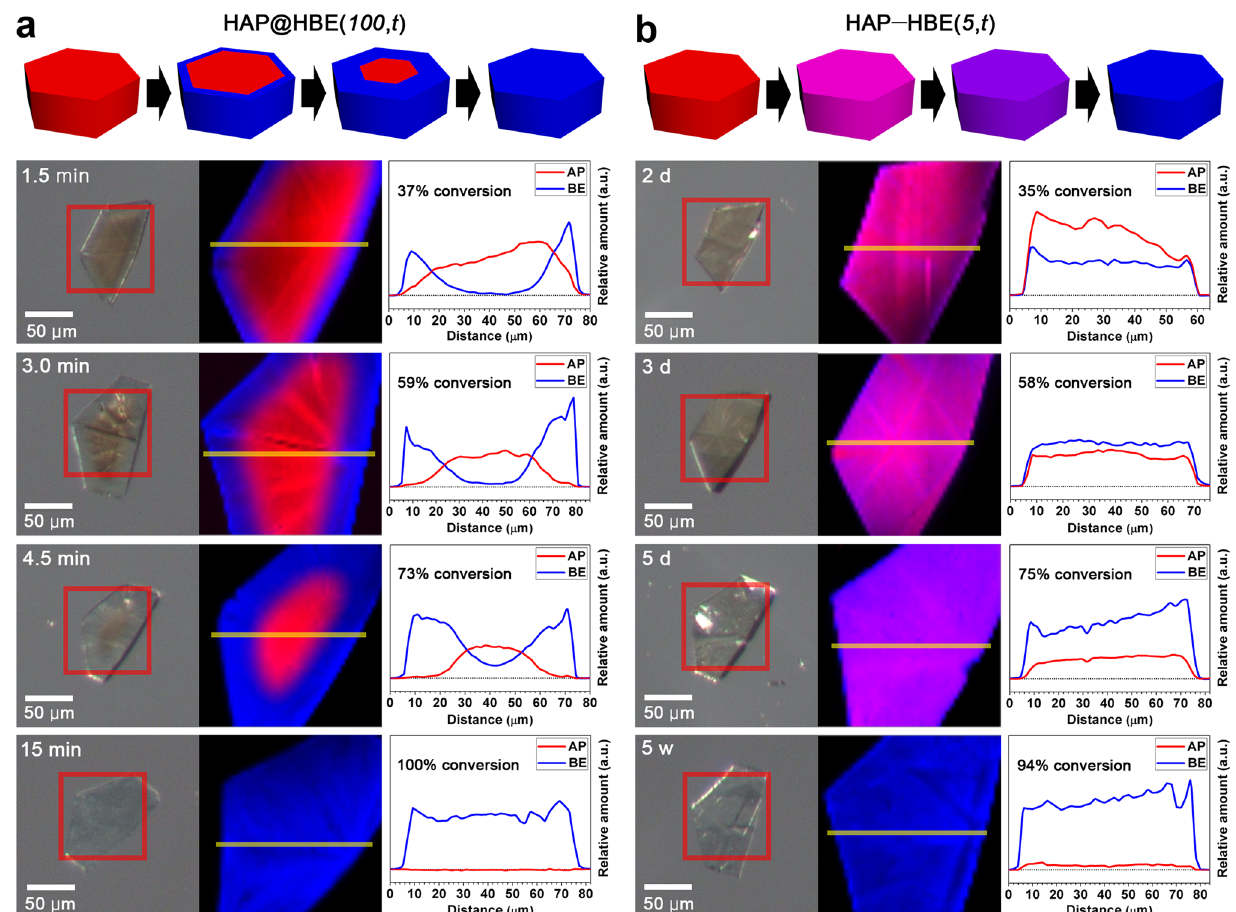
Fig. 3 Raman maps of AP and BE pillars during forward pillar exchange from HAP to HBE. a Schematic diagrams, optical photographs, Raman maps, and relative amounts of AP and BE pillars showing concentric pillar distribution in the core – shell intermediates, HAP@HBE 0.37 (100,1.5m), HAP@HBE 0.59 (100,3m), and HAP@HBE 0.73 (100,4.5m), during pillar exchange from HAP to HAP@HBE 1.00 (100,15m) (i.e., HBE). b Schematic diagrams, optical photographs, Raman maps, and relative amounts of AP and BE pillars showing uniform pillar distributions with different mole fractions of pillars in the uniform intermediates, HAP – HBE 0.35 (5,2d), HAP – HBE 0.58 (5,3d), and HAP – HBE 0.75 (5,5d), during pillar exchange from HAP to HAP – HBE 0.94 (5,5w). In the schematic diagrams and Raman maps of the crystal, red and blue indicate the distribution of AP and BE pillars, respectively, while pink and purple indicate the homogeneous distribution of AP and BE pillars at different mole ratios throughout the